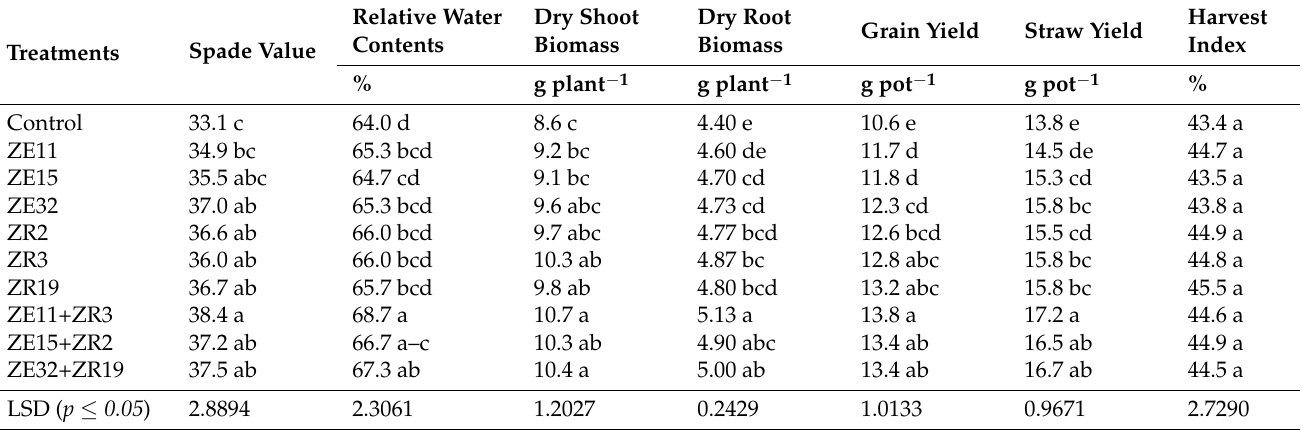
Table 1. Influence of Bacillus and Paenibacillus species on growth, physiology and yield of wheat in a pot